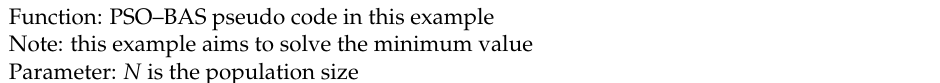
Table 3. The basic steps of the PSO–BAS algorithm.